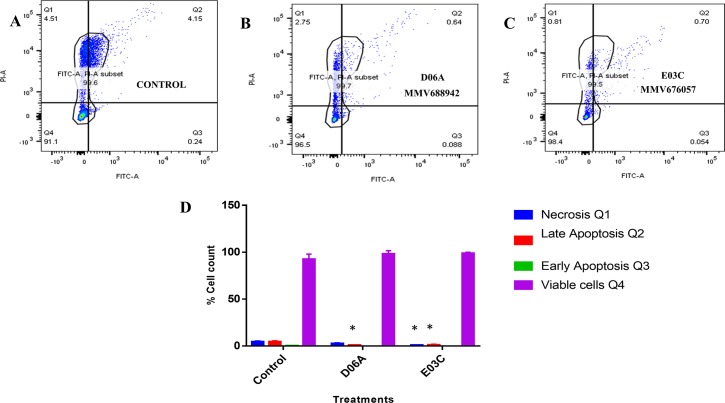
Effect of MMV688942 (D06A) and MMV676057 (E03C) compounds on promastigote cell death.(A) Untreated cells (negative control) and cells treated with (B) MMV688942 (D06A) (2x IC50) (C) MMV676057 (E03C) (2x IC50) (D) Percentage cell quantification of cells in the respective stages. Statistical significance was determined using unpaired t-test by comparing the treated and the control. These are representative profiles of three independent experiments.